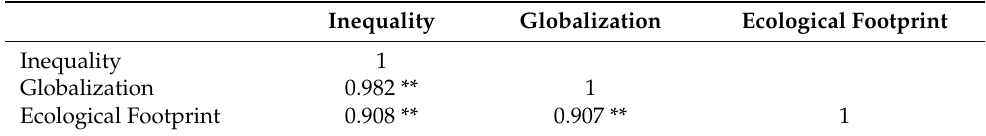
Table 1. Pearson correlation between income inequality, globalization and ecological footprint in China. Own illustration based on